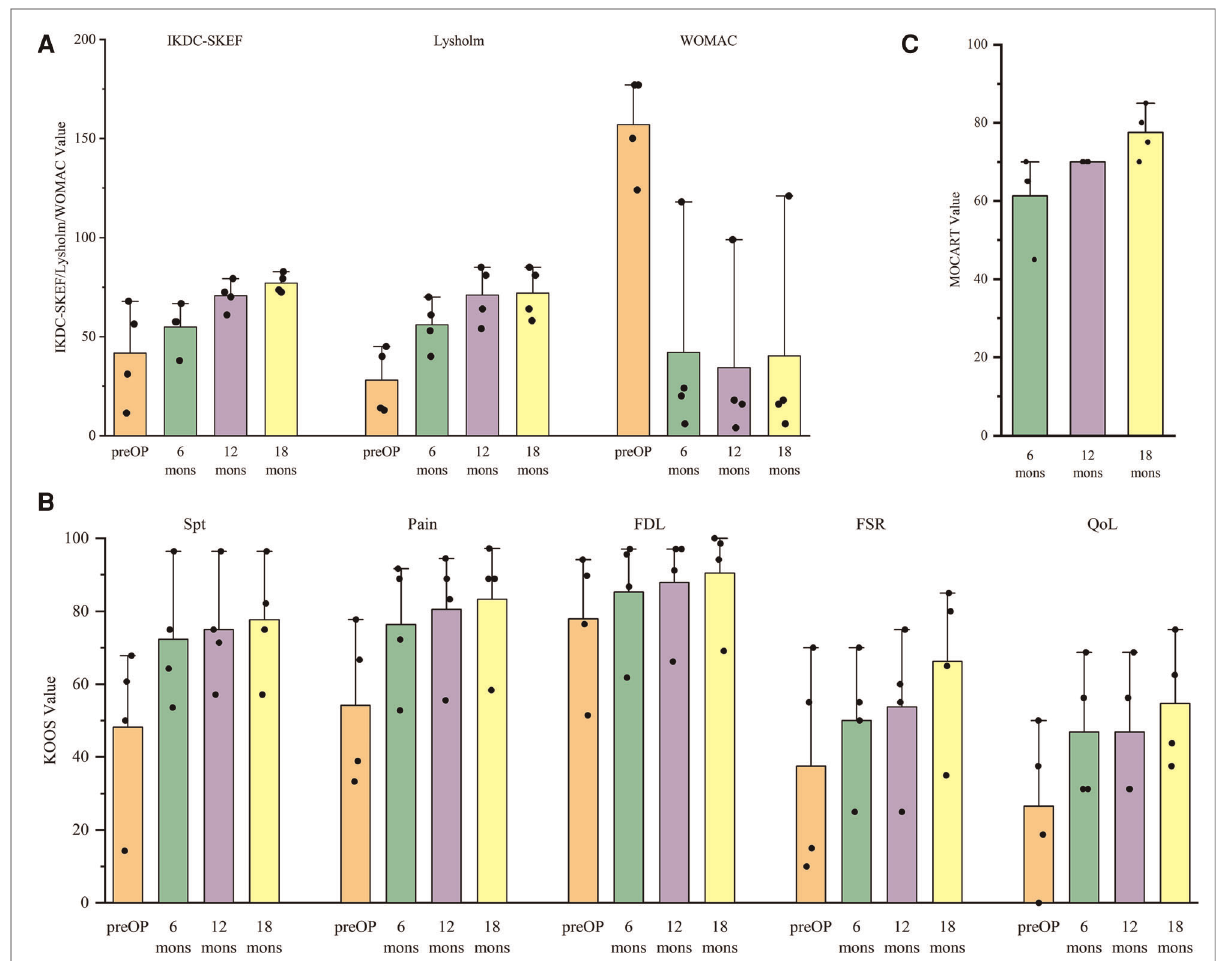
FIGURE 3 Variation in the trend of ( A ) international knee documentation committee subjective knee evaluation form (IKDC-SKEF), lysholm scale, western Ontario and mcMaster universities osteoarthritis Index (WOMAC), ( B ) knee injury and osteoarthritis outcome score (KOOS), and ( C ) magnetic resonance observation of cartilage repair tissue (MOCART)